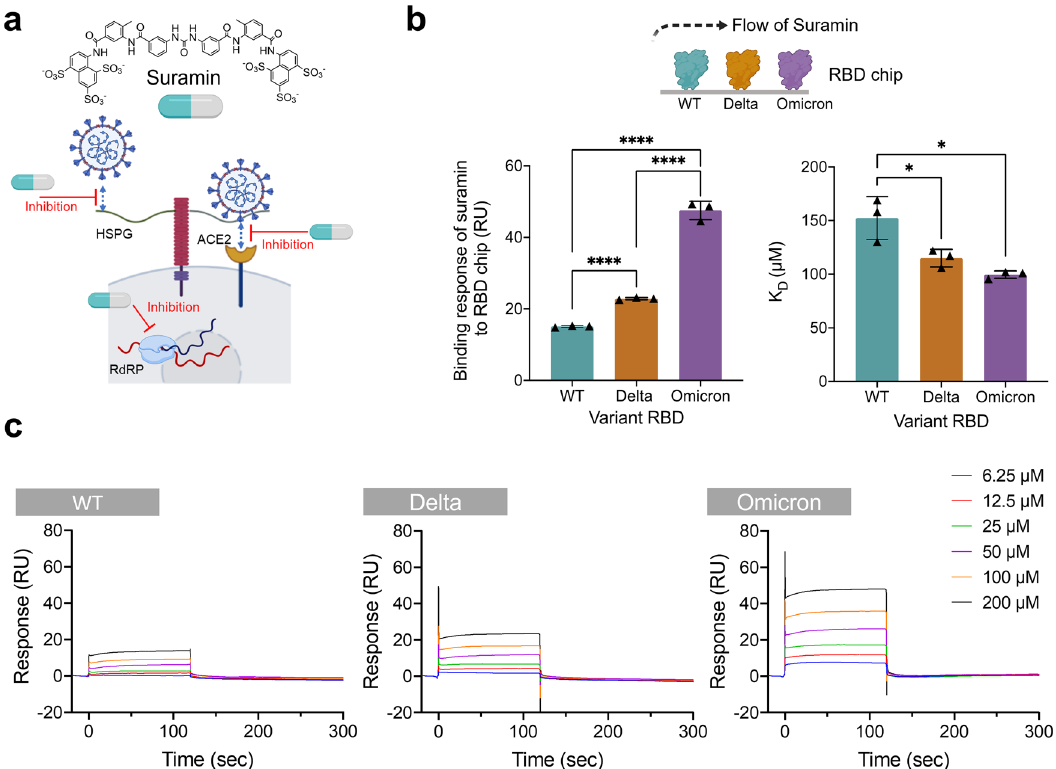
Fig. 1 Suramin interacts with SARS-CoV-2 RBD variants for inhibiting SARS-CoV-2 cell entry. a Structure of suramin and proposed targets. Figure created with Chemdraw and Biorender.com. b SPR assay used to determine the binding af fi nity of suramin with immobilized SARS-CoV-2 variant RBDs (wild type (WT), Delta, and Omicron) on-chip (left panel). Equilibrium binding constants of suramin to RBD of different variants (right panel). c Sensorgrams for binding of suramin to SARS-CoV-2 variants. Various concentrations of suramin (6.25 – 200 µ M in PBS) were fl owed over an RBD chip containing WT, Delta, and Omicron variants on different fl ow cells. For these experiments n = 3 biological replicates. Statistical signi fi cance was determined using a student ’ s t -test with p > 0.05 = ns, * p < 0.05, ** p < 0.01, *** p < 0.001, and **** p <